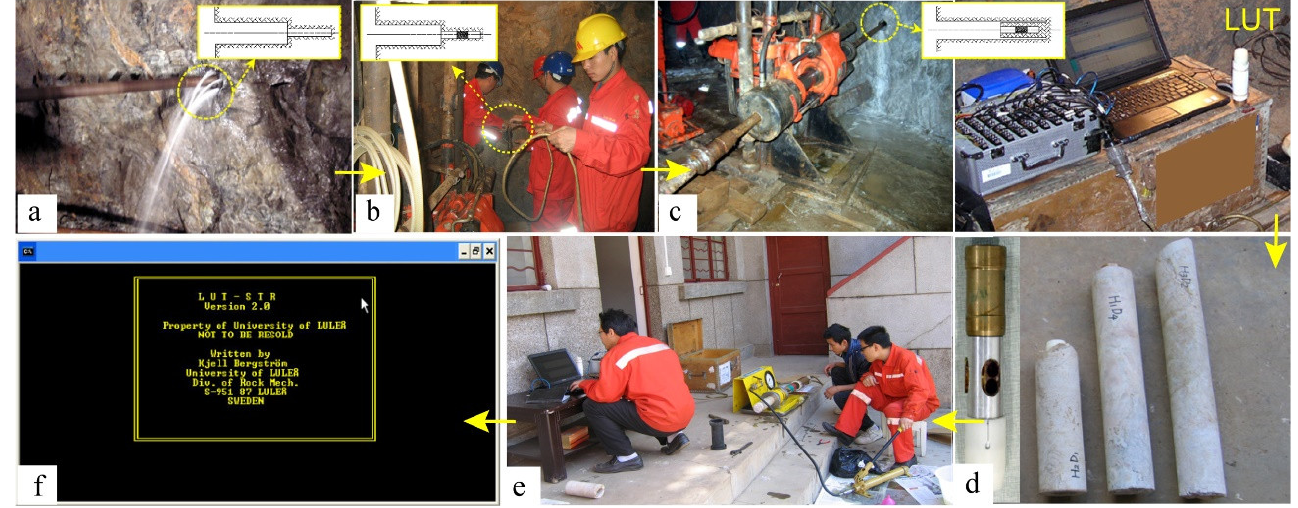
Figure 10. Stress relief process: ( a ) drilling and cleaning; ( b ) installing strain gauge probe; ( c ) stress relief and data acquisition; ( d ) obtaining core tube; ( e ) confining pressure calibration; ( f ) in situ stress calculation.